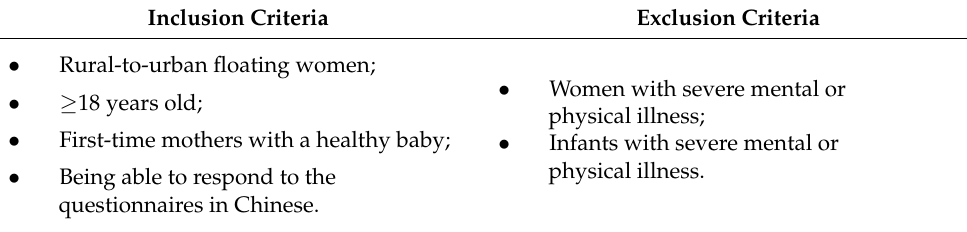
Table 1. Participants’ inclusion and exclusion